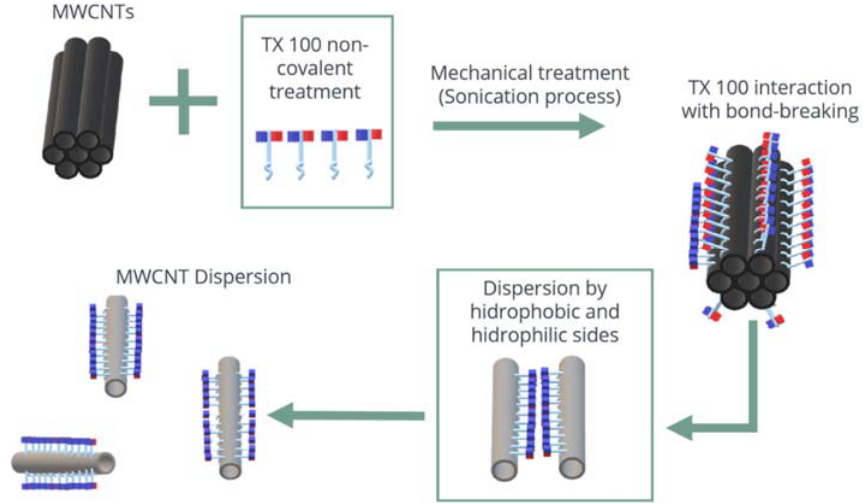
Figure 10. Scheme of the gradual exfoliation processes of the MWCNTs.